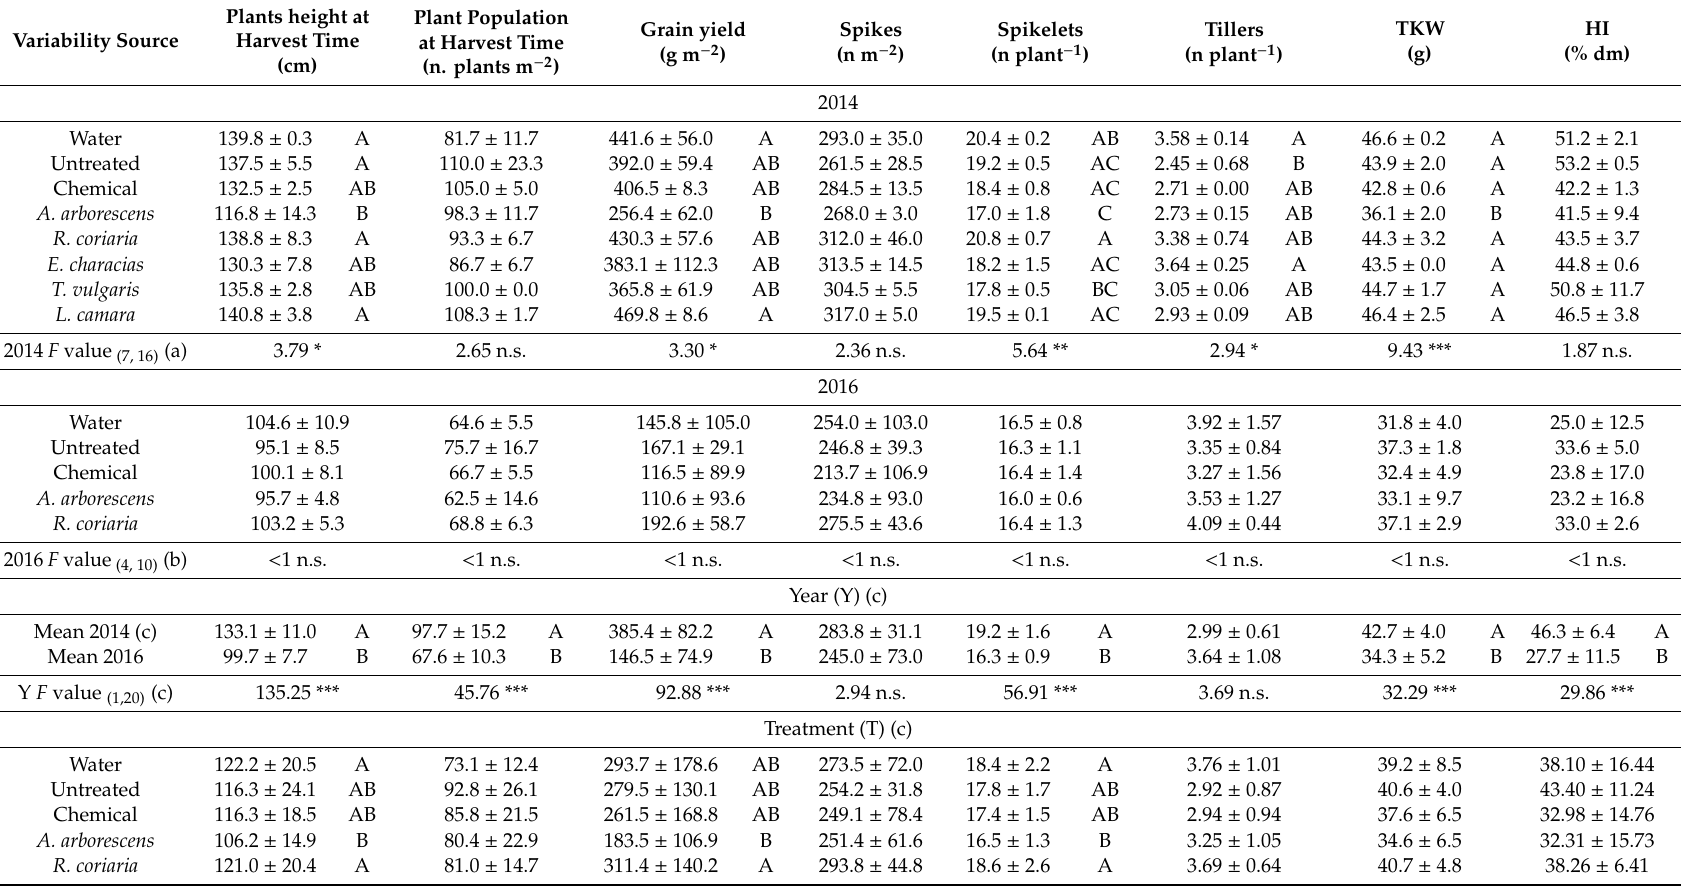
Table 2. Mean e ff ects ± standard deviations of treatment with plant extracts on biometrical and yield traits in durum wheat (cv Valbelice), in comparison with two controls and one chemical weeding, and calculated F values for the treatments. Within each group (2014, 2016, Year, and Treatment), values followed by the same letter are statistically not di ff erent ( p ≤ 0.05, Tukey’s HSD